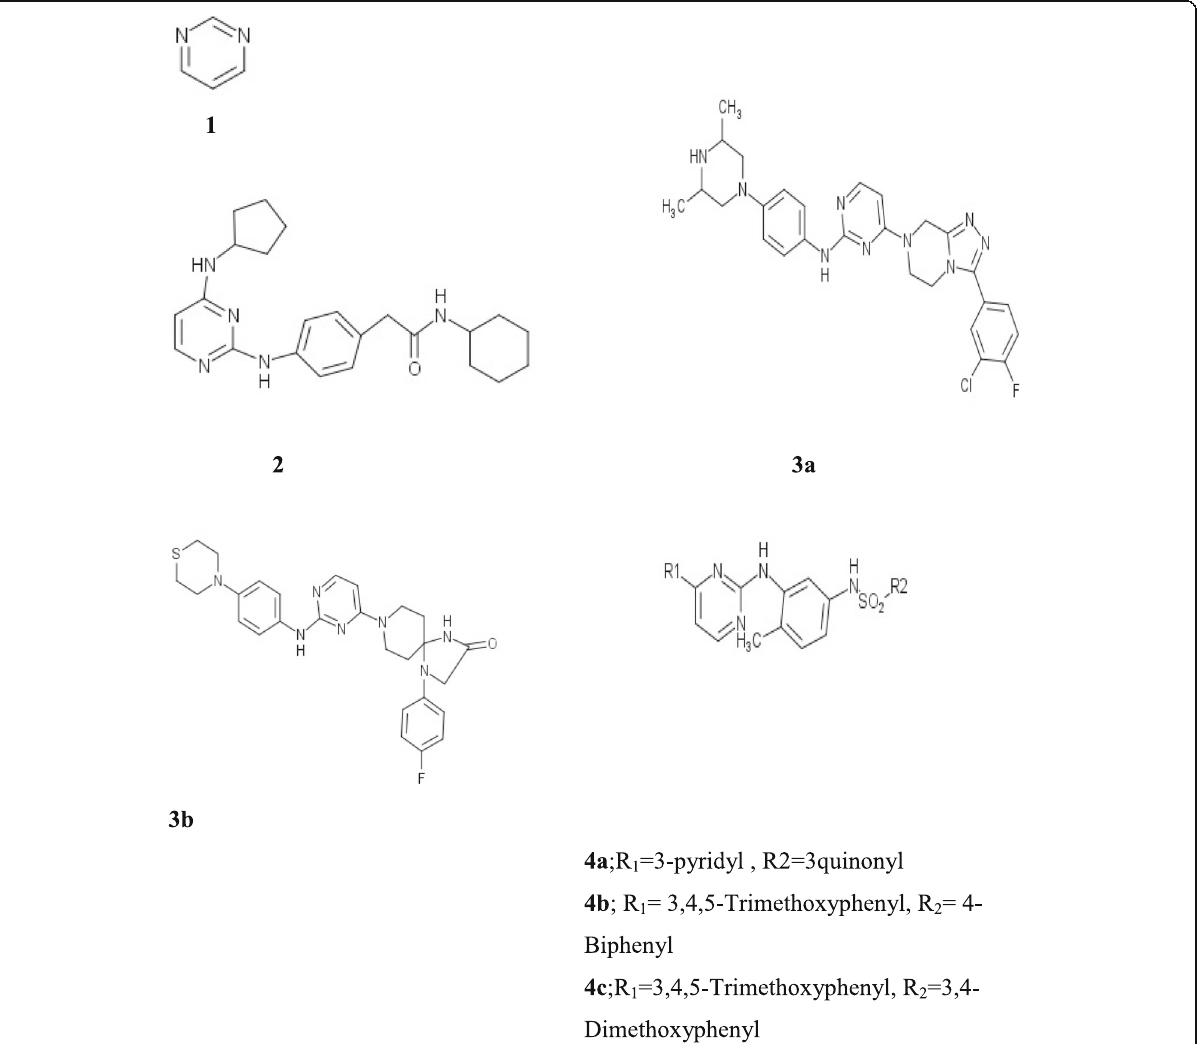
Fig. 1 Chemical structure of 2, 4-disubstituted pyrimidine